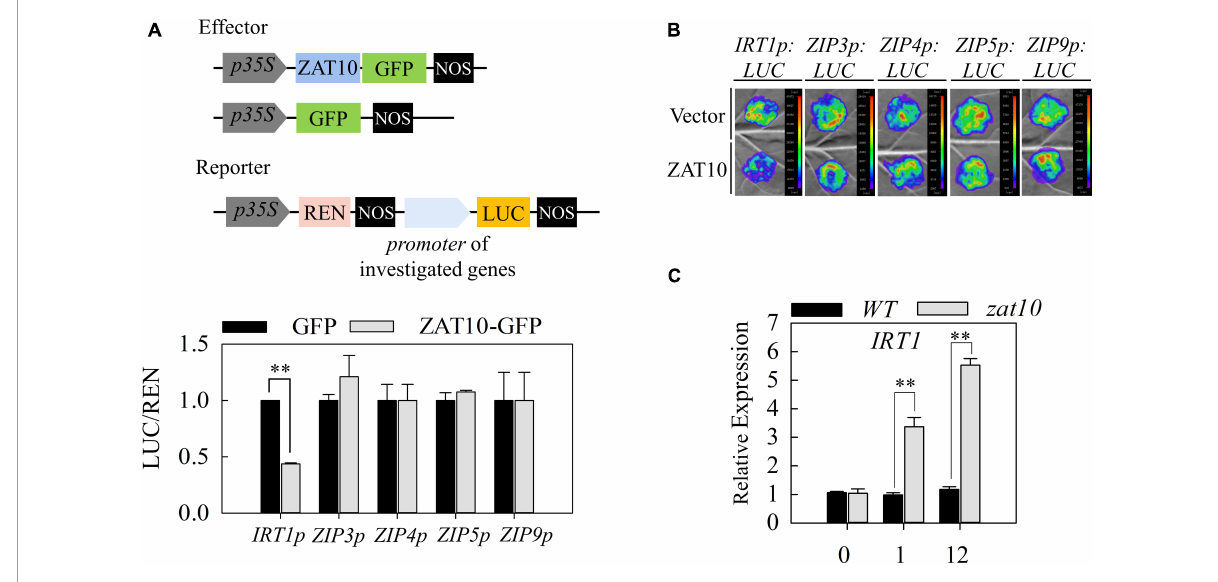
FIGURE4 ZAT10 represses the expression of IRT1 . (A) The schematic drawing of vectors used in dual-luciferase assays. Dual-luciferase assays in Arabidopsis protoplasts show that additional ZAT10 represses the activity of IRT1p:LUC . The REN was used as an internal control. LUC/REN ratio represents the relative activity of the IRT1 , ZIP3 , ZIP4 , ZIP5 , and ZIP9 promoters. Means ± SD, n = 3; ∗∗ P < 0.01, Student’s t -test. (B) ZAT10 represses the transcriptional activity of IRT1 promoter in N. benthamiana leaves. Vectors containing IRT1p:LUC , ZIP3p:LUC , ZIP4p:LUC , ZIP5p:LUC , or ZIP9p:LUC were co-infiltrated with the empty vector or ZAT10 overexpression vector in N. benthamiana leaves as indicated. Images were taken at 48 h after infiltration. At least three replicates were measured with similar results. (C) Relative expression of IRT1 in the wild-type and zat10 mutant plants at 0, 1, and 12 h post treatment (hpt) with 30 µ M CdSO 4 . Means ± SD, n = 3; ∗∗ P < 0.01, Student’s t